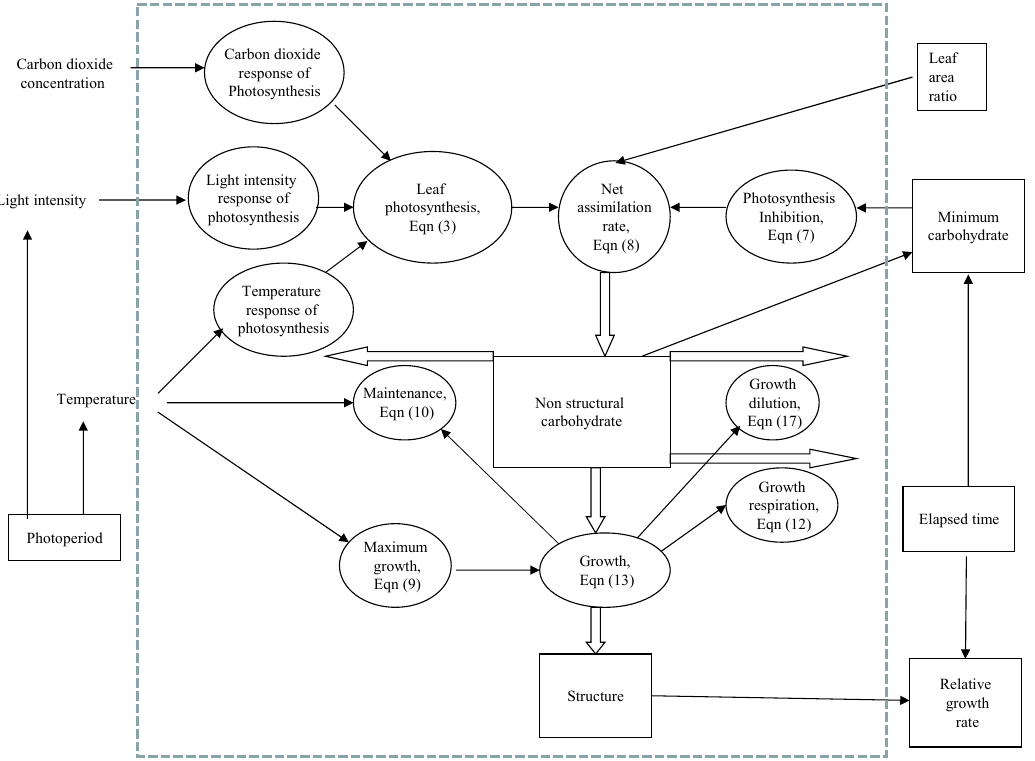
Figure 1. Schematic diagram of the hourly calculations of the dynamic model. Rectangles indicate state variables. Those outside the calculation are daily variables. Ellipses indicate rate equations. Text values are driving variables. The flow of NSC is indicates by thick arrows. Influences on rate equations are indicated by thin arrows.